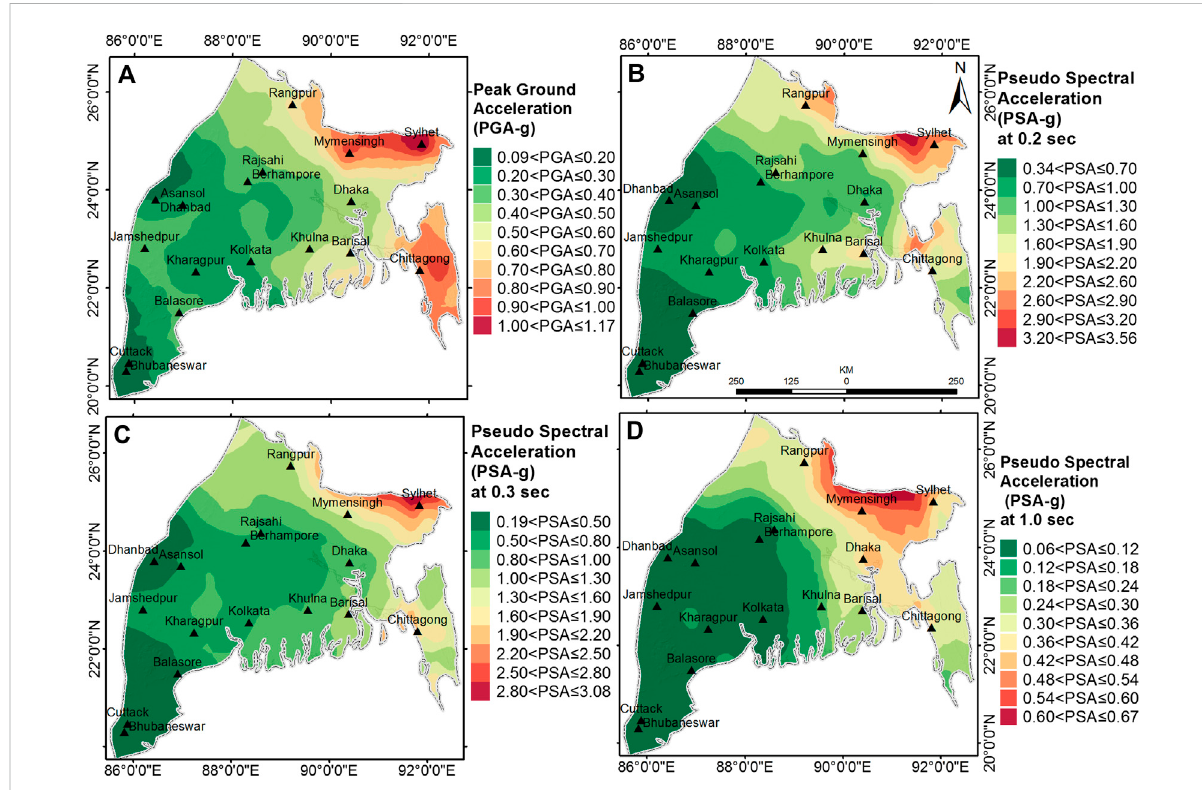
FIGURE 9 Spatial distributions of surface-consistent (A) peak ground acceleration and pseudo spectral acceleration at (B) 0.2s, (C) 0.3 s, and (D) 1.0 s, respectively, for 10% probability of exceedance in 50 years in Bengal